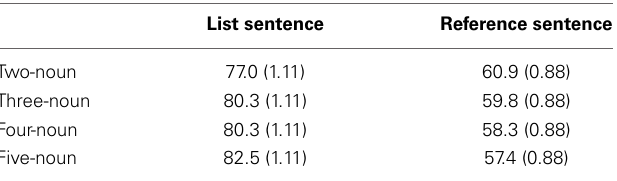
Table 4 | Experiment 1B mean per-character reading times in ms (with standard errors of the